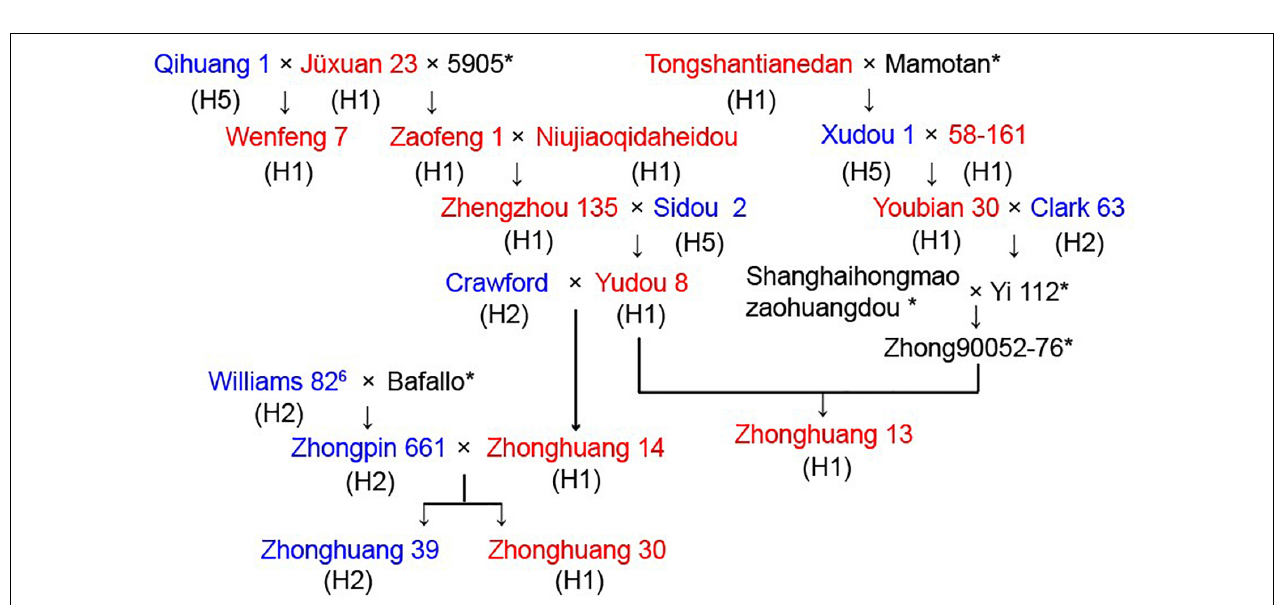
FIGURE 6 | Pedigree of four soybean cultivars for the salt tolerance gene GmSALT3 . Salt tolerance of each cultivar is indicated in red (tolerant), blue (sensitive), and haplotypes (H1–H5) are shown in parentheses under the name of cultivar. * indicate seeds of these cultivars were unavailable.